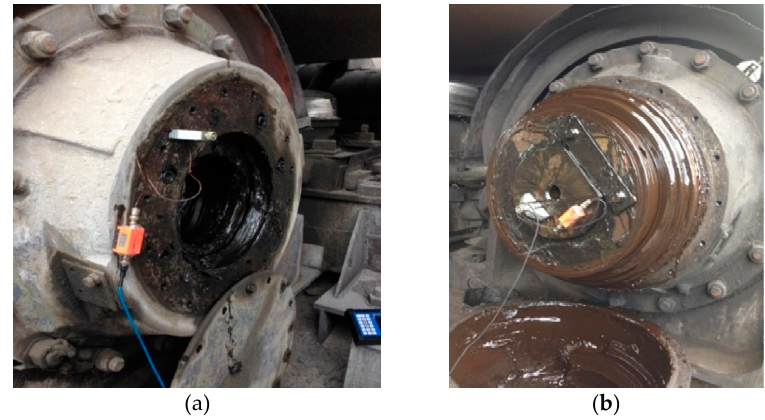
Figure 19. Sensors mounted at bearing housing ( a ) and at the end of the roller bearing ( b ) with the protective caps removed.